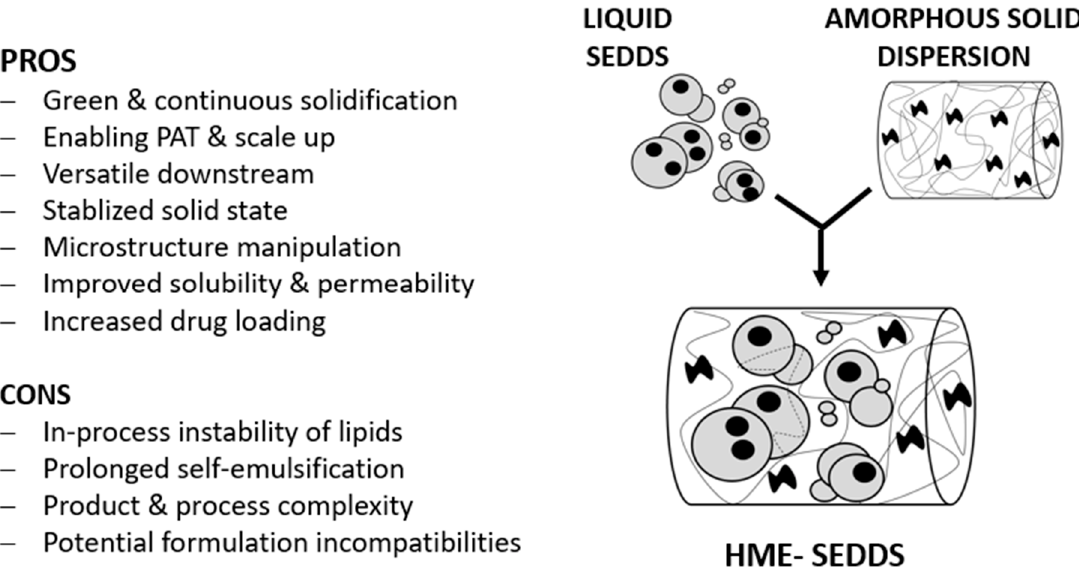
Figure 8. Pros and cons of the prepared HME–SEDDSs compared with conventional liquid SEDDSs and amorphous solid dispersions.